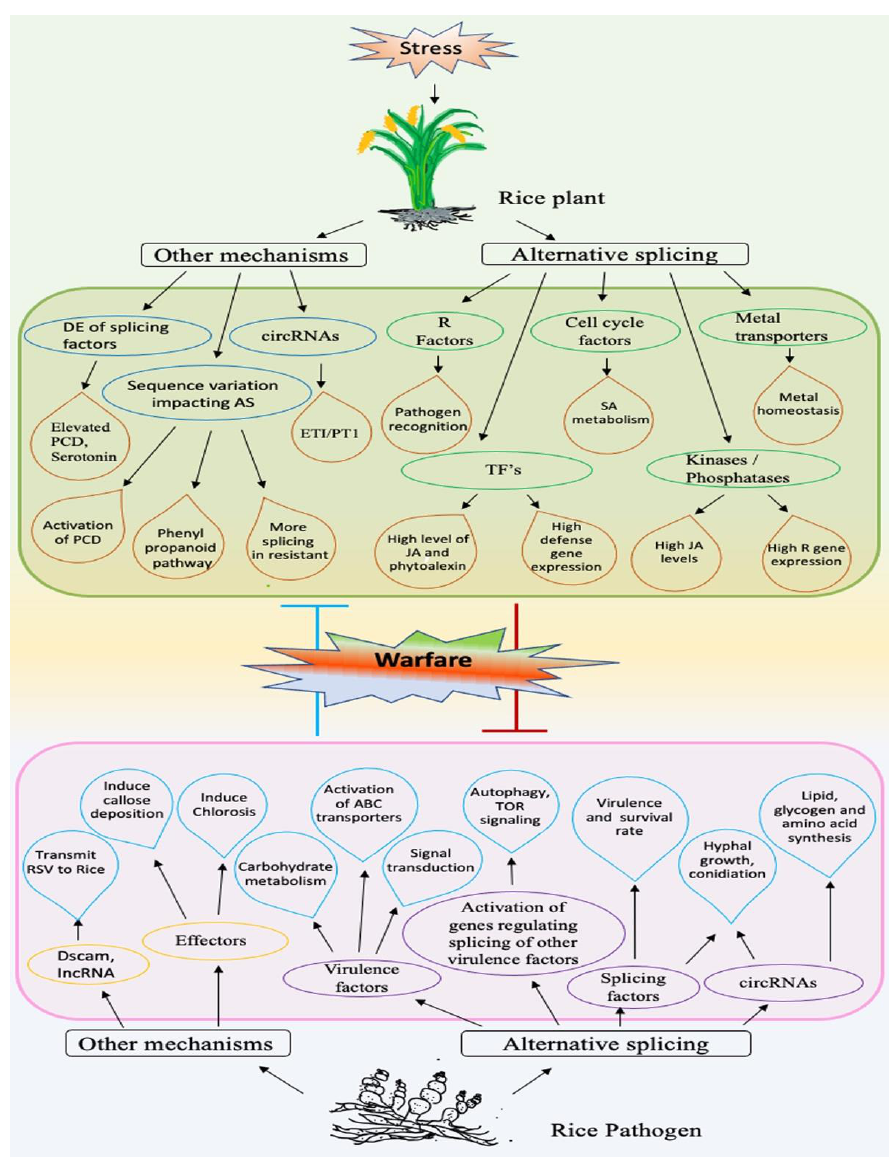
Figure 3. Participation of potential AS-mediated defense and offense processes in rice-pathogen interaction. Based on the published reports, the role of AS in the virulence of various pathogens and the potential AS-mediated processes that rice employs to counter stresses are shown. Besides the processes where genes are directly alternatively spliced, other mechanisms that regulate the expression of splicing factors and circRNAs, or the impact of sequence variations among different genotypes on AS, are also shown. AS, alternative splicing; CircRNAs, circular RNAs; DE, differential expression; ETI, effector-triggered immunity; JA, jasmonate; lncRNA, long noncoding RNA; PCD, programmed cell death; PTI, PAMP-triggered immunity; RSV, rice stripe virus; SA, salicylic acid; TAR, target of rapamycin; TFs, transcription factors.